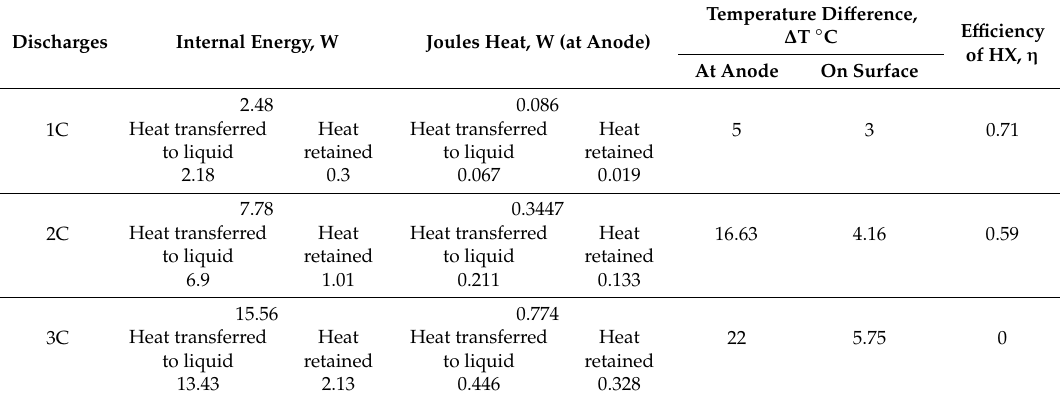
Table 5. The theoretical results for the internal energy, joules heat, e ffi ciency of the heat exchanger (HX), and increase in measured temperature during discharges.